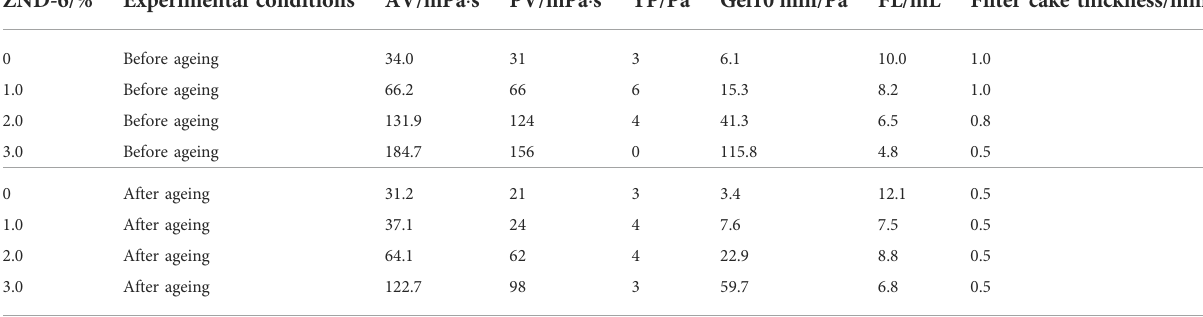
TABLE 2 Compatibility of ZND and Polysulfonic Drilling Fluid (150 ° C for 16 h of aging).